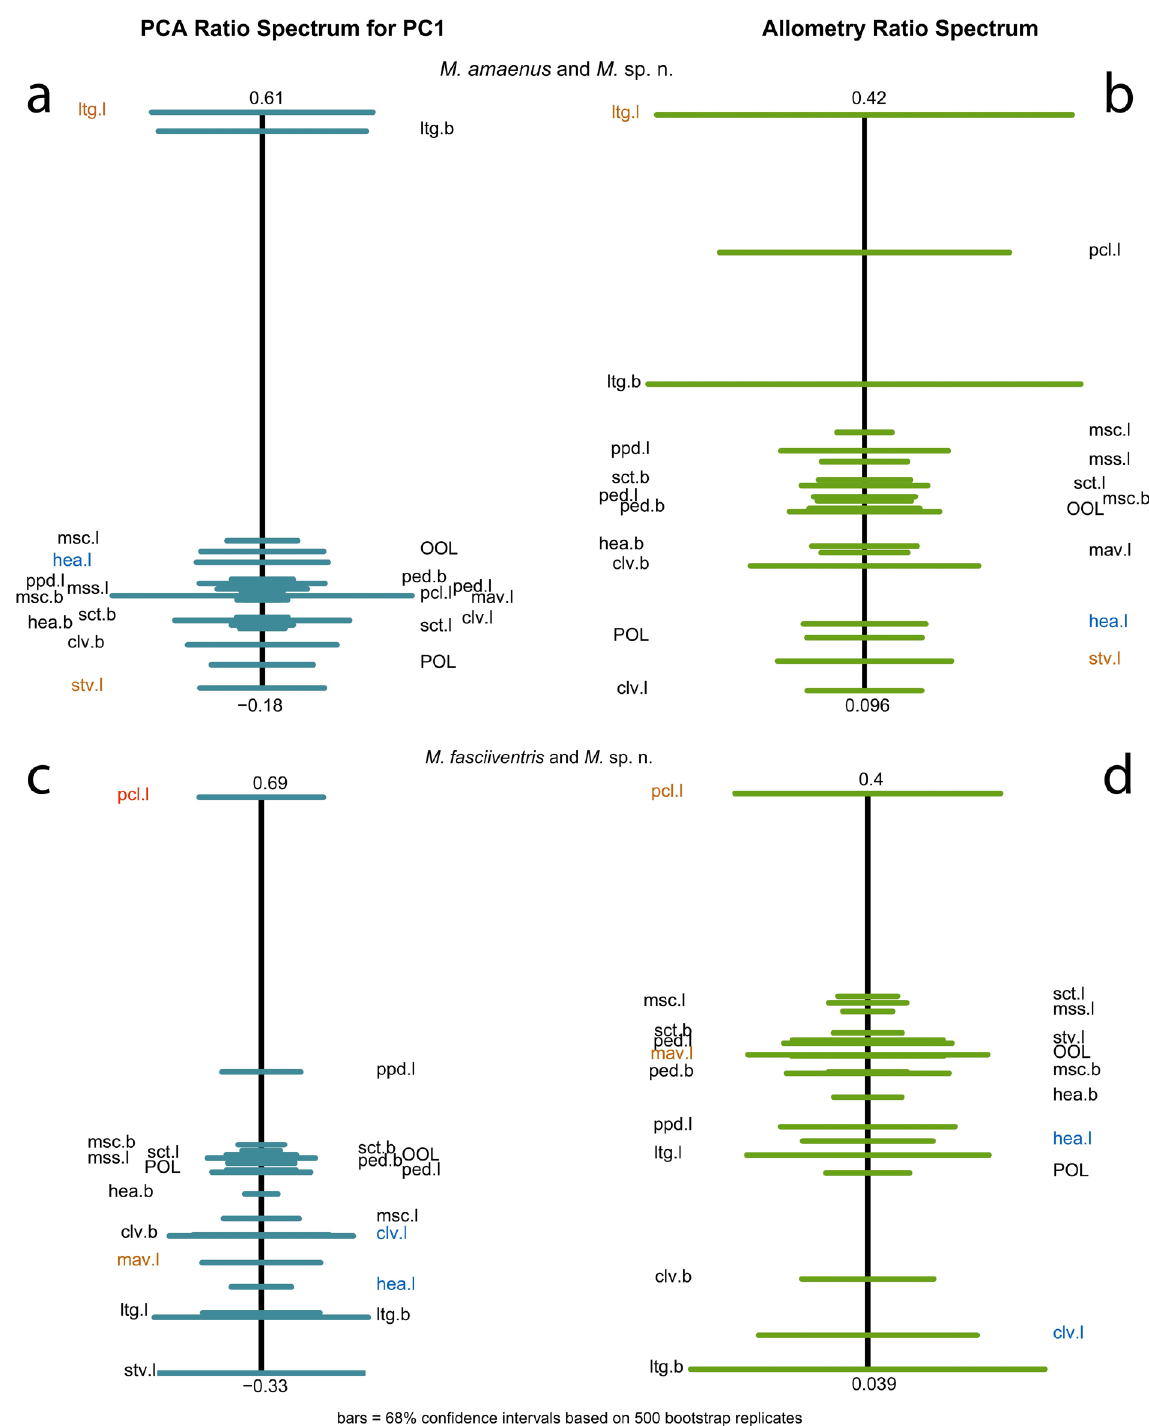
Fig. 2. Ratio spectra for the species pairs. a, c . PCA ratio spectrum. b, d . Allometry ratio spectrum. a . The two species pairs. b . Mesopolobus amaenus (Walker, 1834) and Mesopolobus robiniae Lakatos & László sp. nov. c–d . M. fasciiventris Westwood, 1833 and Mesopolobus robiniae Lakatos & László sp. nov. Horizontal bars in the ratio spectra represent 68% bootstrap confidence intervals based on 1000